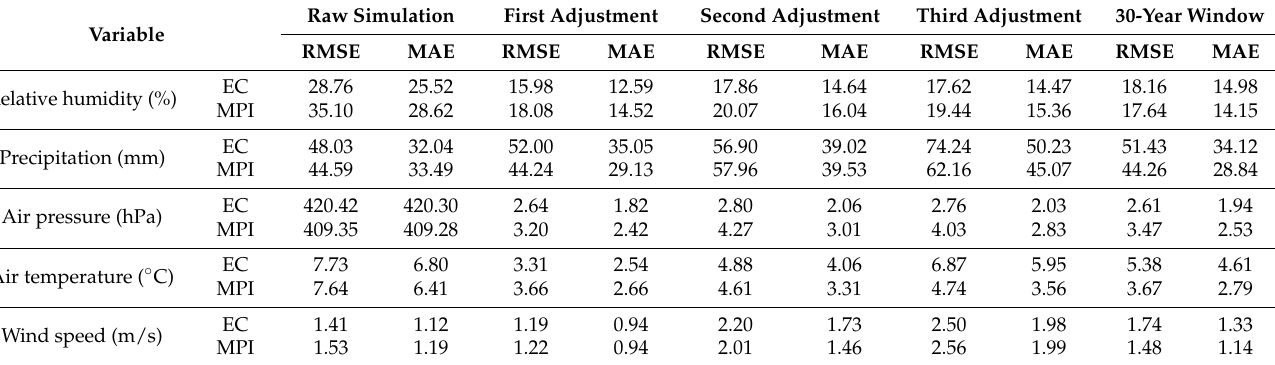
Table 4. Changes of RMSE and MAE values at the Naqu site as the adjustment proceeds and the adjustment window varies. Raw simulation and the first adjustment refer to the raw GCM simulations and the calibrated results in 1970–1984, the second adjustment, 1985–1999 and the third adjustment, 2000–2014. The next adjustment depends on the calibrated results in the preceding adjustment as control or the observations in 1955–1969 as the initial control (for the first adjustment). The metrics are measured against the site observations. The column titled 30-year window is the calibrated results in 1985–2014 using a 30-year adjustment window, which temporally contains the second and third adjustments using 15-year window. N = 180 for the 15-year time window and N = 360 for the 30-year time